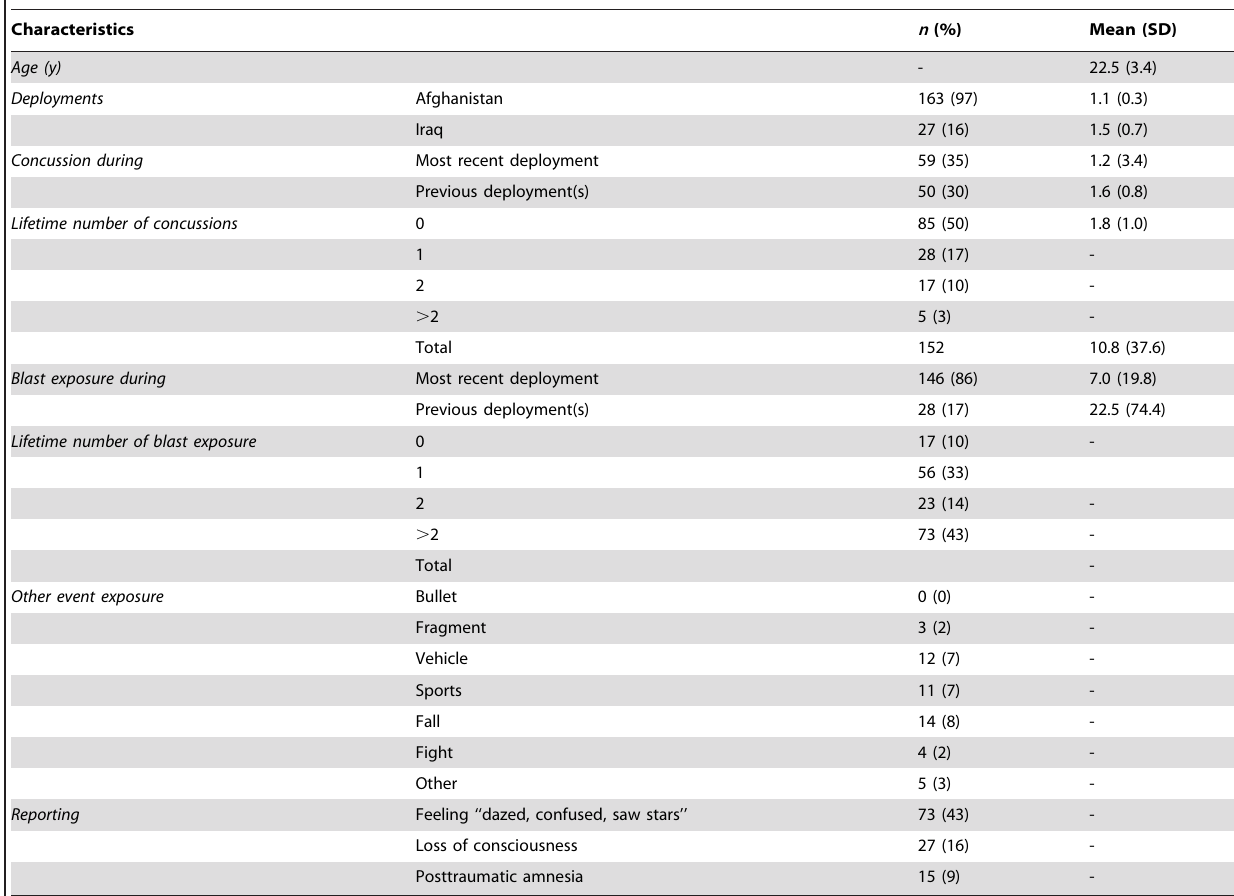
Table 1. Sample characteristics ( n